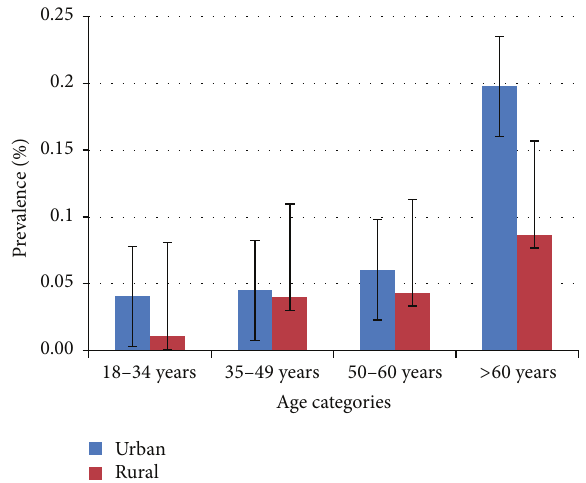
Figure 2: Age-specific prevalence of diabetes in urban and rural